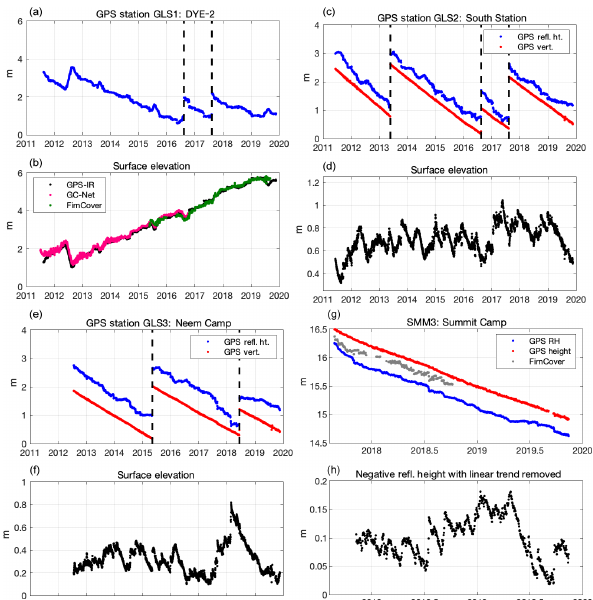
Figure 3. (a) GLS1 reflector heights; (b) surface elevation for GLS1 compared to in situ measurements from GC-Net and FirnCover; (c) GLS2 reflector heights (blue) and geocentric verticals (red); (d) sur- face elevation for GLS2; (e) GLS3 reflector heights (blue) and geo- centric verticals (red); (f) surface elevation for GLS3; (g) SMM3 reflector heights (blue) and geocentric verticals (red), and in situ measurements from FirnCover; (h) SMM3 reflector heights with linear trend removed and sign change. All GPS verticals are defined with respect to the center of the Earth, and thus a constant has been removed before plotting